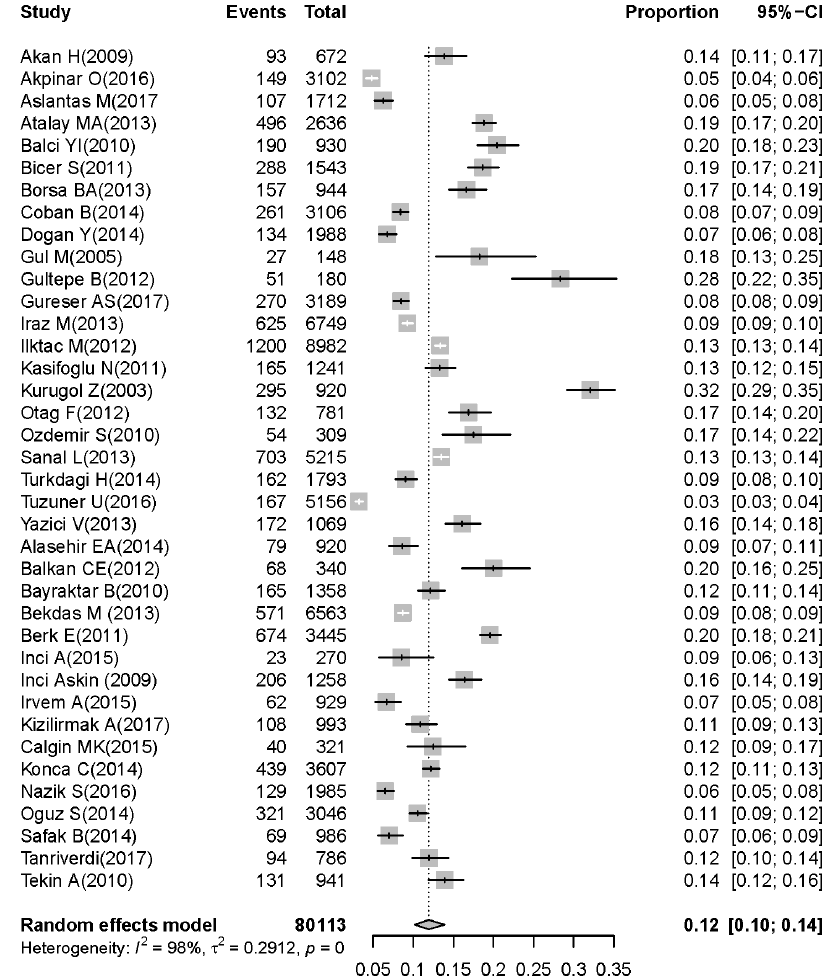
Figure 3. Prevalence of rotavirus-associated acute gastroenteritis cases in children aged 0 – 2 years.